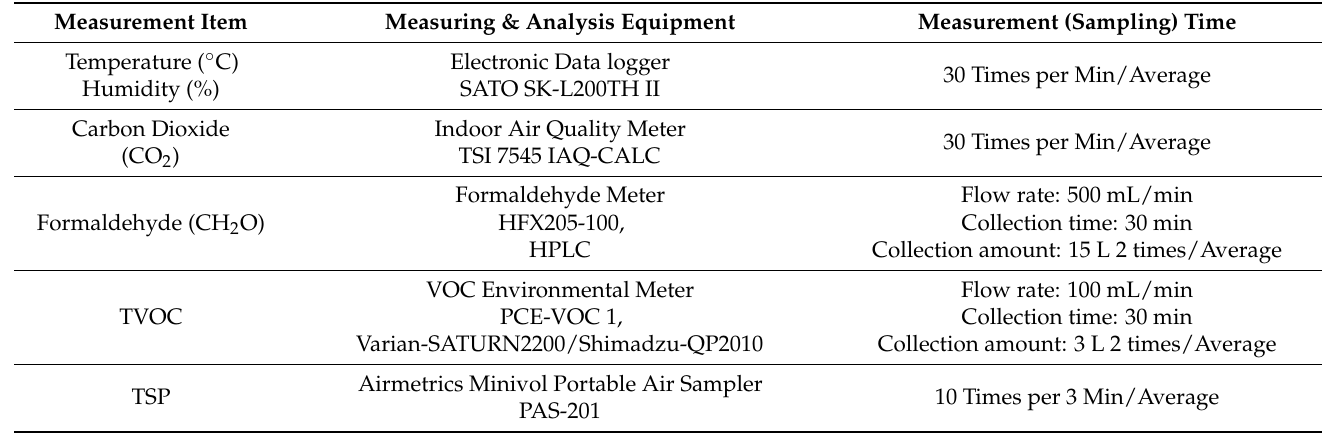
Table 2. Indoor Air Pollutants Measuring Devices and Methods.